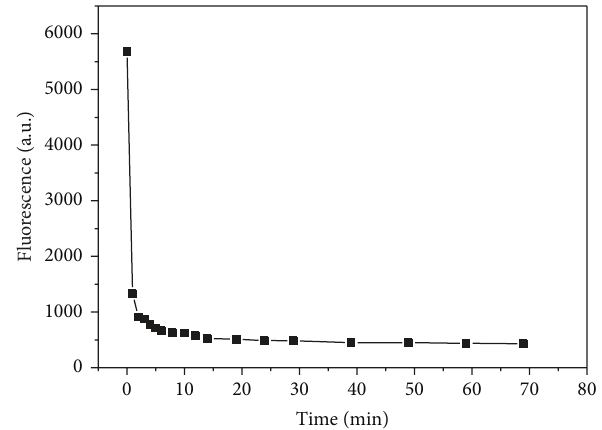
Figure 3: Fluorescence intensity decay of ThT upon the addition of